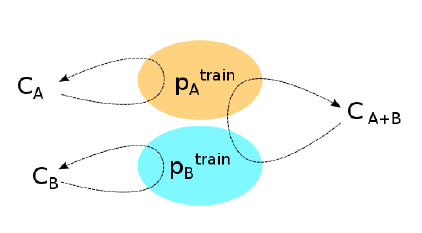
Figure 7. Training two classifiers on two different datasets and one classifier on both